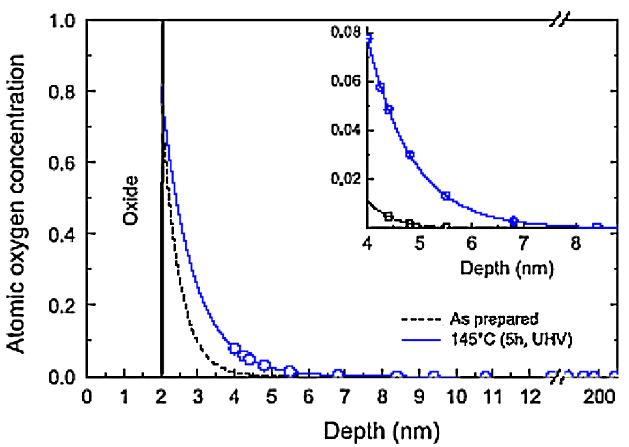
FIG. 2. (Color) Atomic oxygen concentration profile as a func- tion of depth into Nb below the oxide layer, measured using x- ray diffuse scattering on a single-crystal Nb sample before and after baking. The figure is taken from Ref. [17].